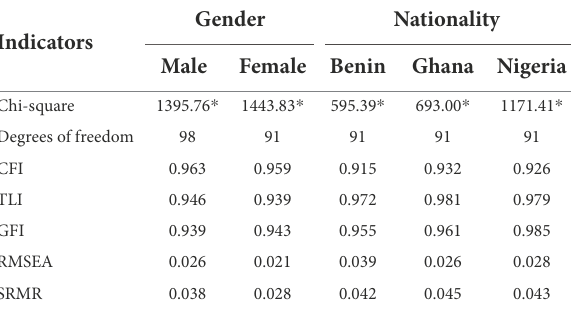
TABLE 4 Measurement invariance for gender and